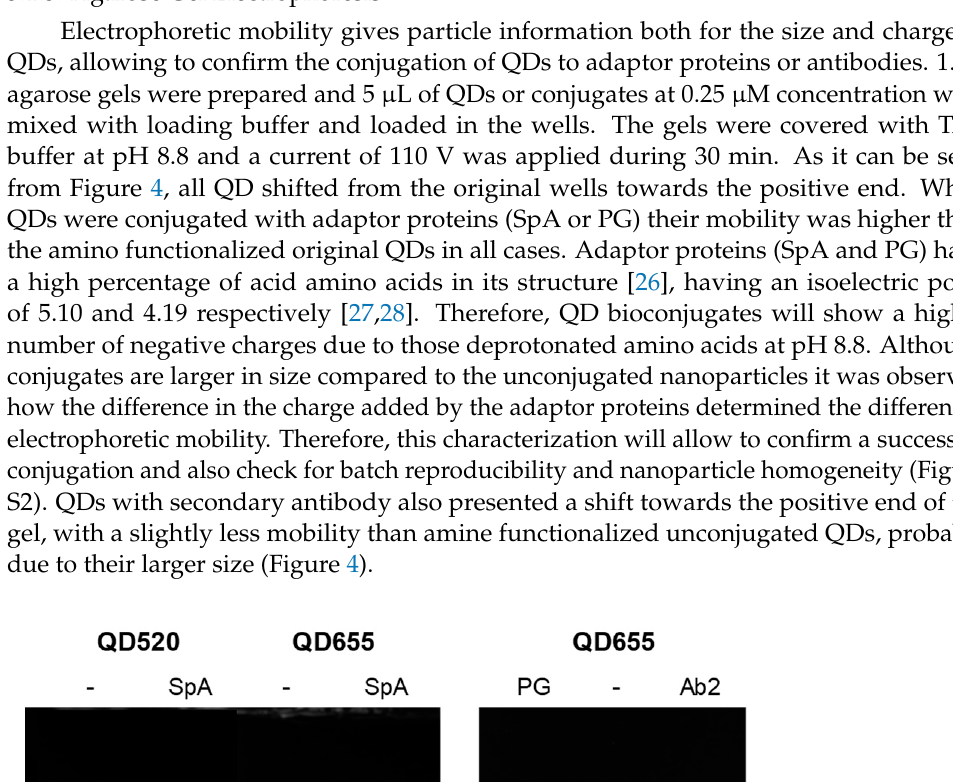
h between unconjugated QDs, QD-SpA and QD-